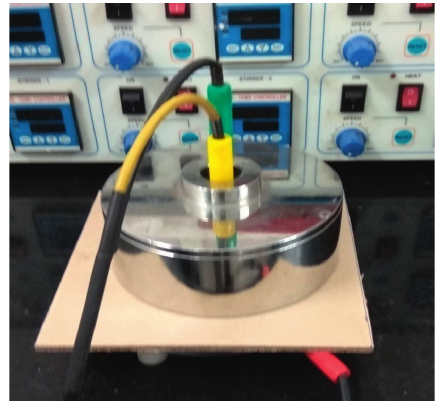
Figure 9: Testing of the normal press board.